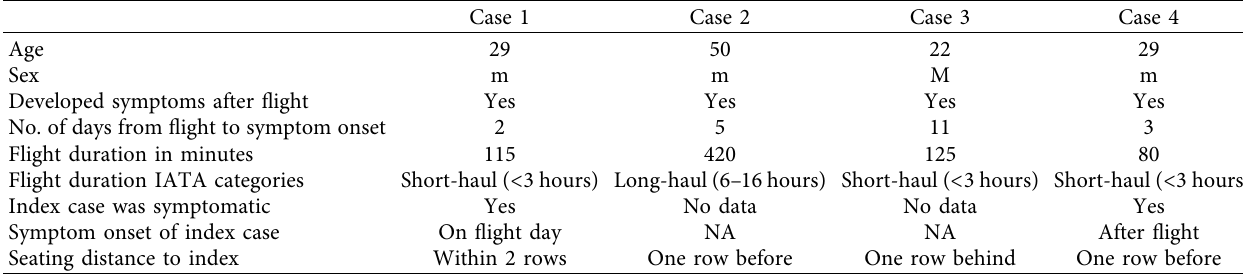
Table 2: Details of four probable in-flight transmissions, COVID-19 flight contact tracing study, Germany,